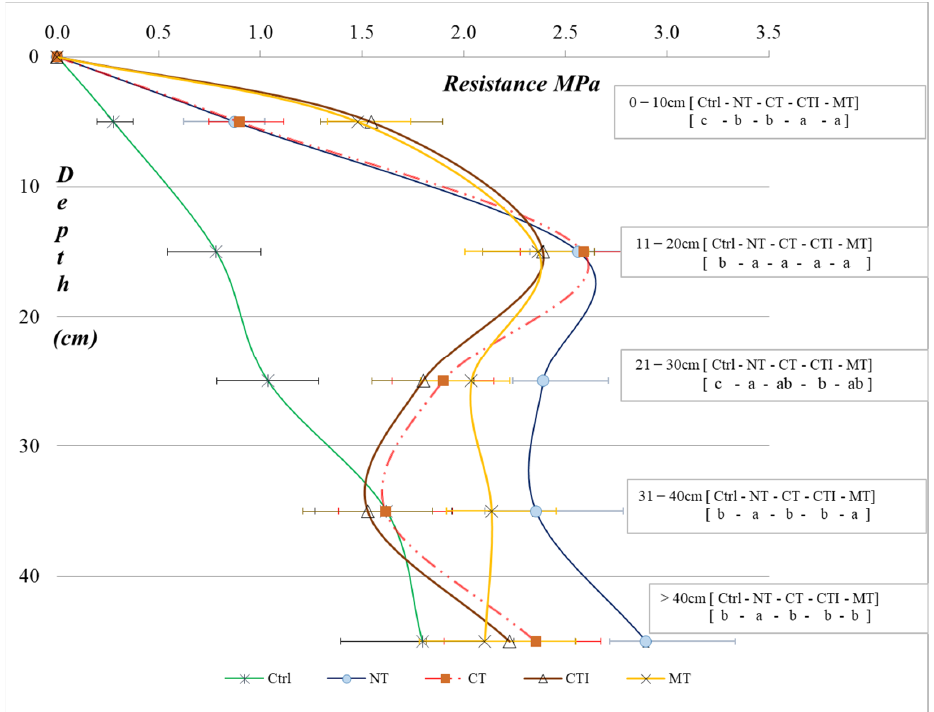
Figure 3. SPR inter rows of sugarcane (traffic line) at different soil depths for treatments: control (Ctrl); no ‐ tillage (NT); minimum cultivation (MT); conventional preparation (CT), and conventional preparation I (CTI). In the boxes next to the graph, means followed by the same letter for each depth interval do not differ by Tukey’s test, at 5% significance.